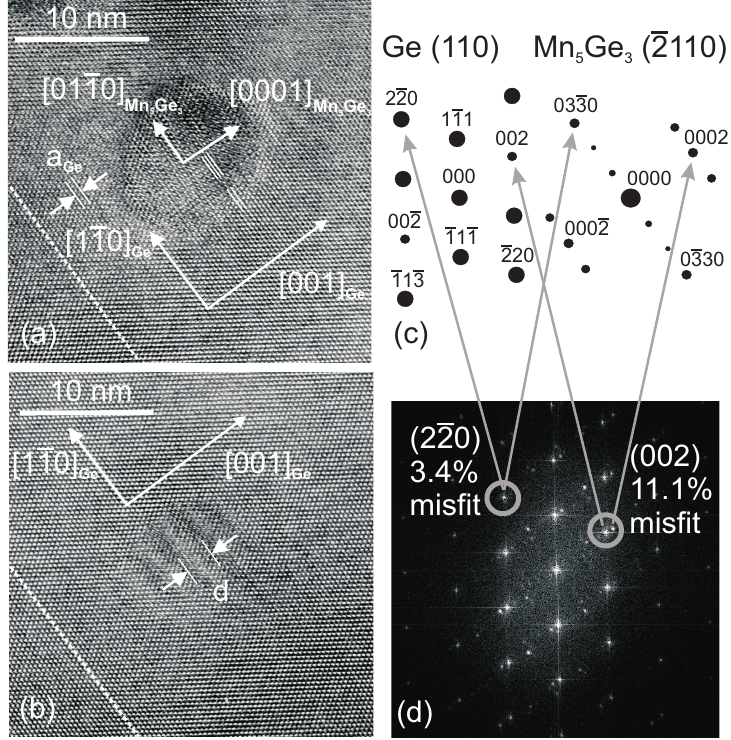
Figure 3 . (a) and (b) HR-TEM images of typical clusters in Mn of the wafer-layer interface is marked by dashed lines. (c) Standard diffraction patterns of Ge(110) and Mn Ge (110). (d) Calculated FFT pattern of (a). (Reprinted with permission 5 3 from Ref. [31]. Copyright 2006, American Institute of Physics).